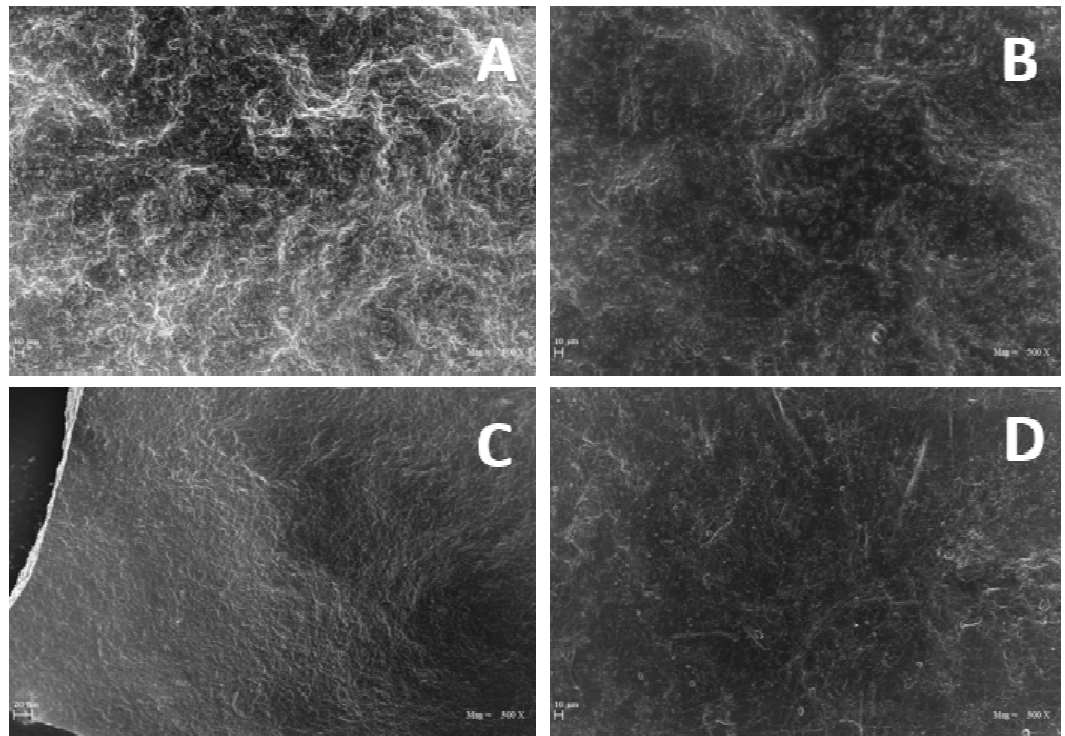
Figure 6. SEM micrographs of the surfaces (500× magnification) of films obtained with dialyzed PGA (800 mg) at pH 3.5 in the absence ( A ) and presence of 1% ( B ), 2% ( C ), and 4% ( D ) GLY. The images shown were chosen as the most representative of each sample. Further experimental details are given in the text.